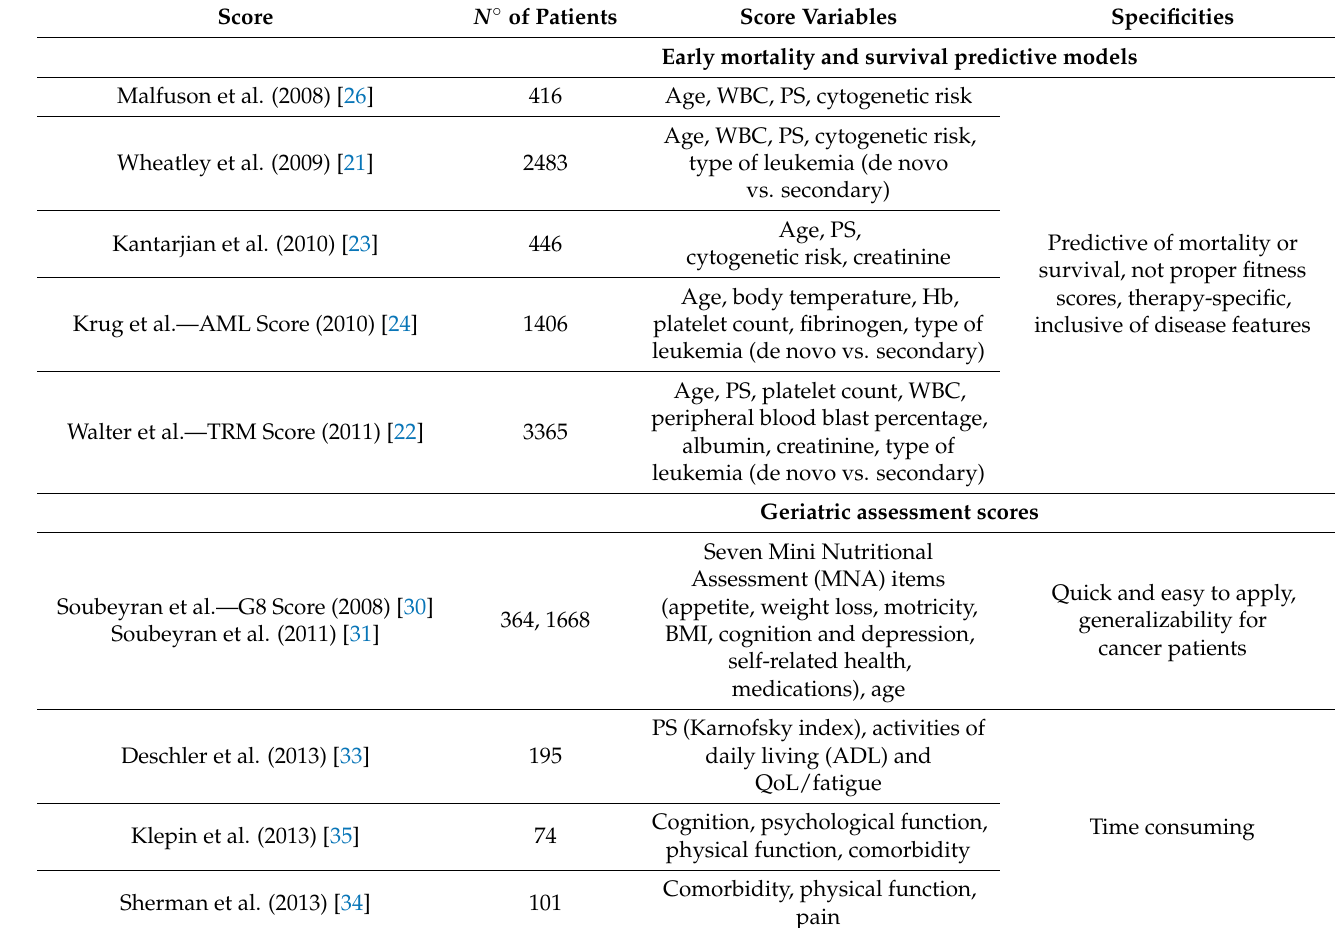
Table 1. Different models and scores to assess patients’ fitness and eligibility for intensive chemotherapy. Score N ◦ of Patients Score Variables